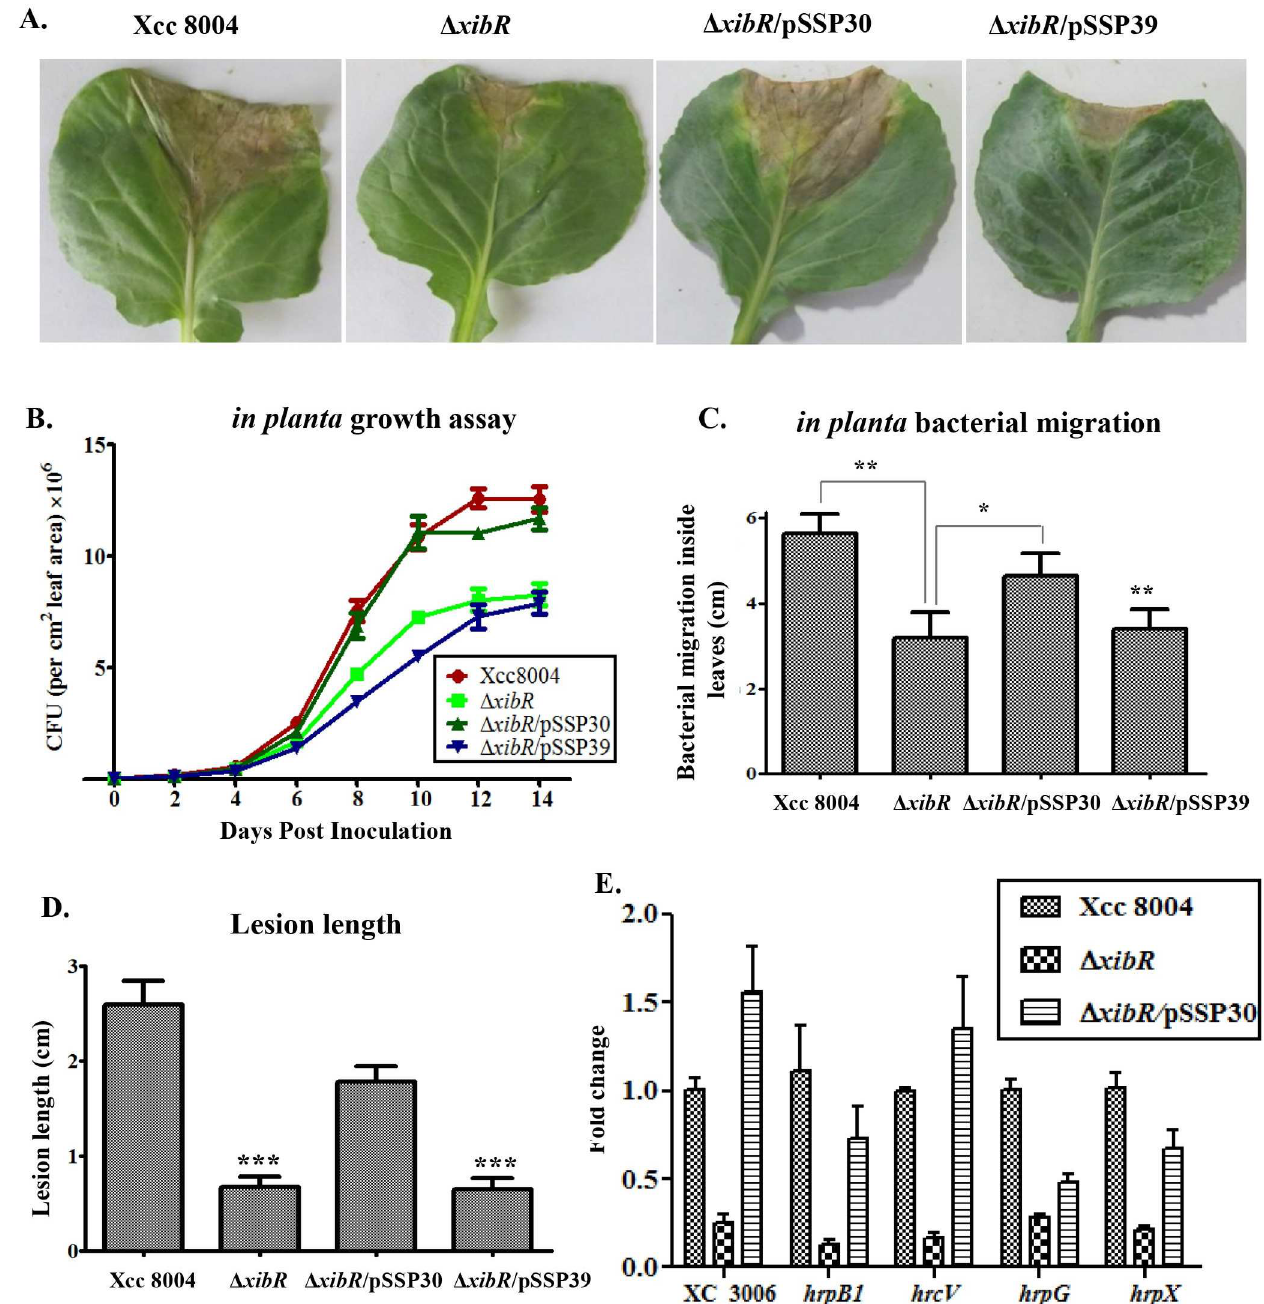
Fig 8. xibR is required for optimal virulence. (A) Infected cabbageleaves with different Xcc strain showingsymptoms as a lesion at 15 days postinoculation. 30 days old plants were inoculated with bacterialcultures (1 X 10 9 cells/ml suspension)of different Xcc strains by clip method. (B) In planta growth assays of Xcc 8004, Δ xibR , Δ xibR /pSSP30 and Δ xibR /pSSP39 strains. Bacterial populationswere measuredby crushingthe leaves of 1cm 2 areas for each and serial dilutionplatingat the indicatedpost inoculation days. Data are shown as mean ± S.E. (n = 3). (C) In planta bacterialmigrationassay was performed by inoculating 1cm pieces of infected leave, cut from base to tip with sterile scissors on rich PS medium with respectiveantibiotics. Migration was estimated by observingcoloniesformed after 1 to 3 days by the bacterialooze from the cut ends of cabbageleaf pieces. (D) Quantificationof lesion length at 15 days post inoculation.Data shown as mean ± S.E. (n = 25). (E) Relative quantification of the expressionof different Type III secretionsystem hrp genes of Xcc 8004, Δ xibR ,and Δ xibR /pSSP30 strains by real-time qRT-PCR. * Indicatingp-value < 0.05, ** indicating p-value < 0.01 and *** indicating p-value < 0.001 statisticallysignificanceby pairedstudent t- test.